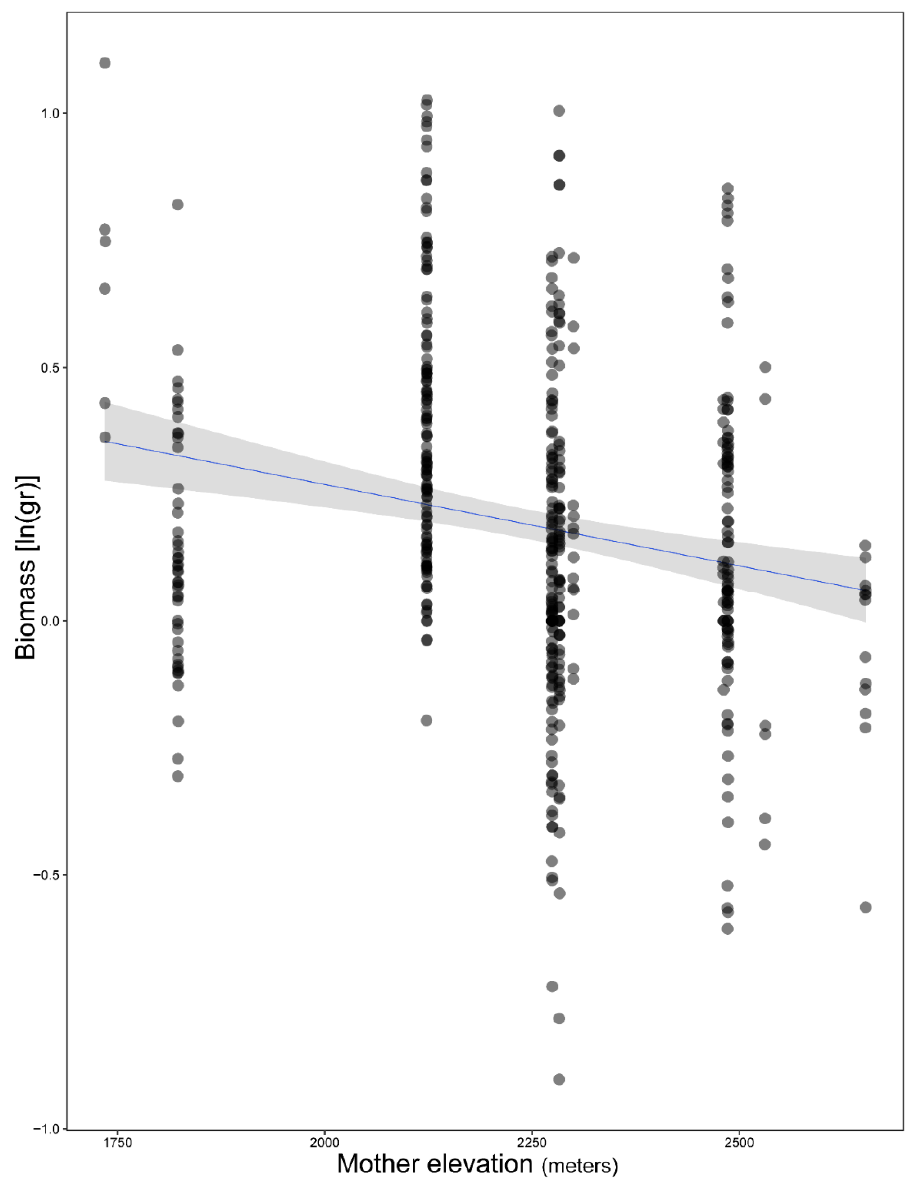
Figure 3. Relationship between Erebia caterpillars’ performance and mother’s elevation (i.e., sam- pling site elevation of mother’s origin). Each dot corresponds to an individual’s mass at a specific elevation.